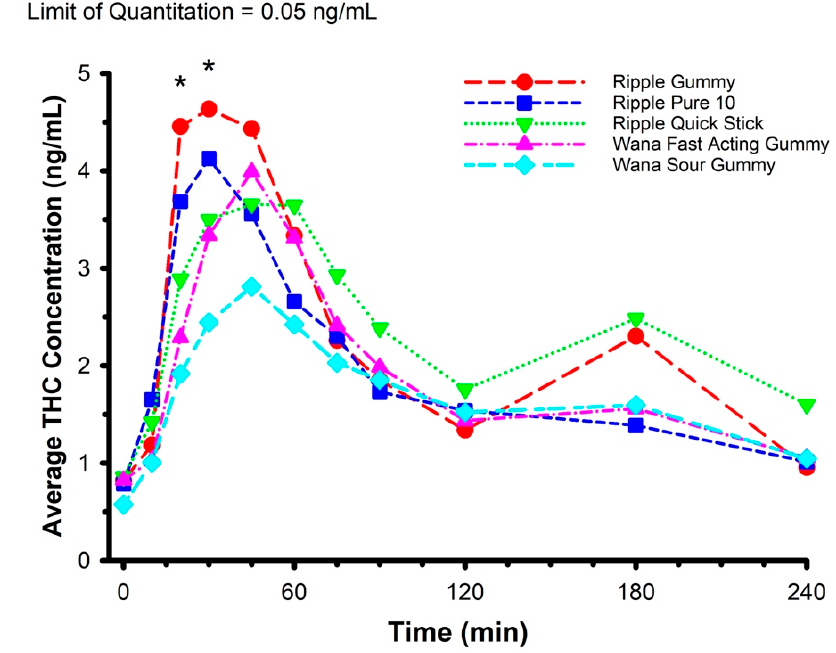
Figure 2. Mean circulating concentrations of THC following ingestion of commercially available edible marijuana (10 mg of THC). * Represents product × time interaction ( p = 0.019). Post hoc analysis revealed circulating THC concentration was greater in Ripple Blood Orange Gummies vs. Wana Fast Acting Gummies ( p = 0.003) and Wana Sour Gummies ( p < 0.001) at 20 min, and greater in Ripple Blood Orange Gummies vs. Wana Sour Gummies ( p = 0.002), and Ripple Pure 10 vs. Wana Sour Gummies ( p = 0.038) at 30 min. Error bars have been omitted for clarity.